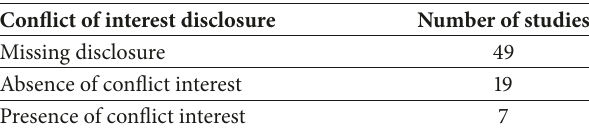
Table 5: Disclosure of conflict of interests in included